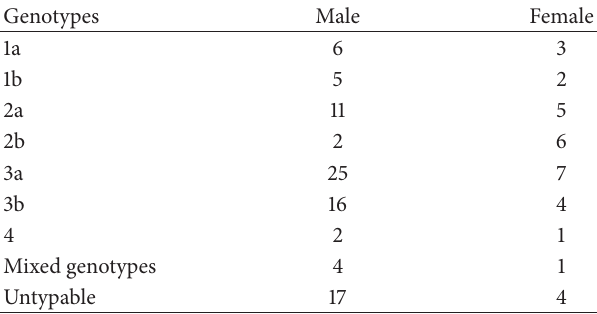
Table 2: Gender-wise distribution of HCV genotypes.